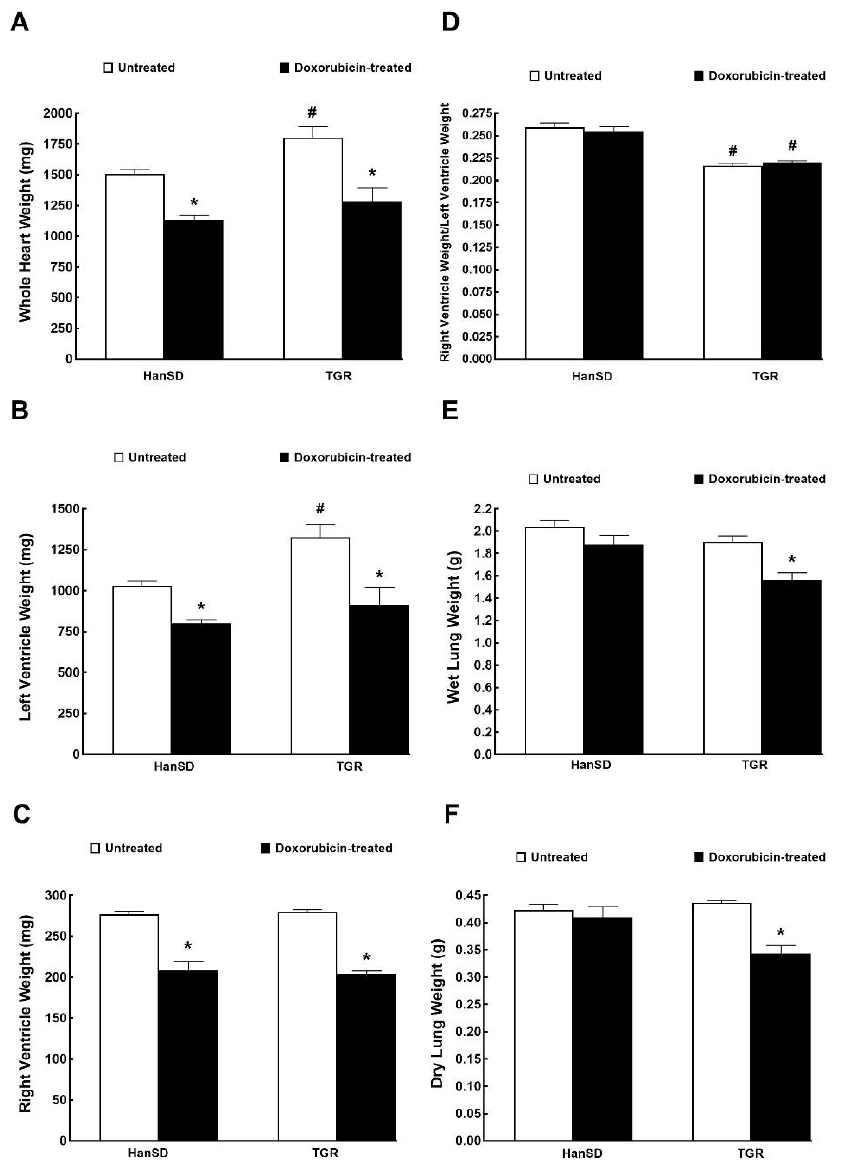
Figure 4. Whole heart weight ( A ), weights of individual components of the heart ( B , C ), their ratio ( D ) and wet and dry lung weights ( E , F ) two weeks after the last doxorubicin injection (i.e., at the end of the experimental protocol) in normotensive, transgene-negative Hannover Sprague-Dawley (HanSD) and hypertensive, Ren-2 transgenic (TGR) rats. * p < 0.05 compared with untreated animals of the same strain. # p < 0.05 versus HanSD rats within the same protocol. The values are means ± SEM and are pooled from the three series of experiments.